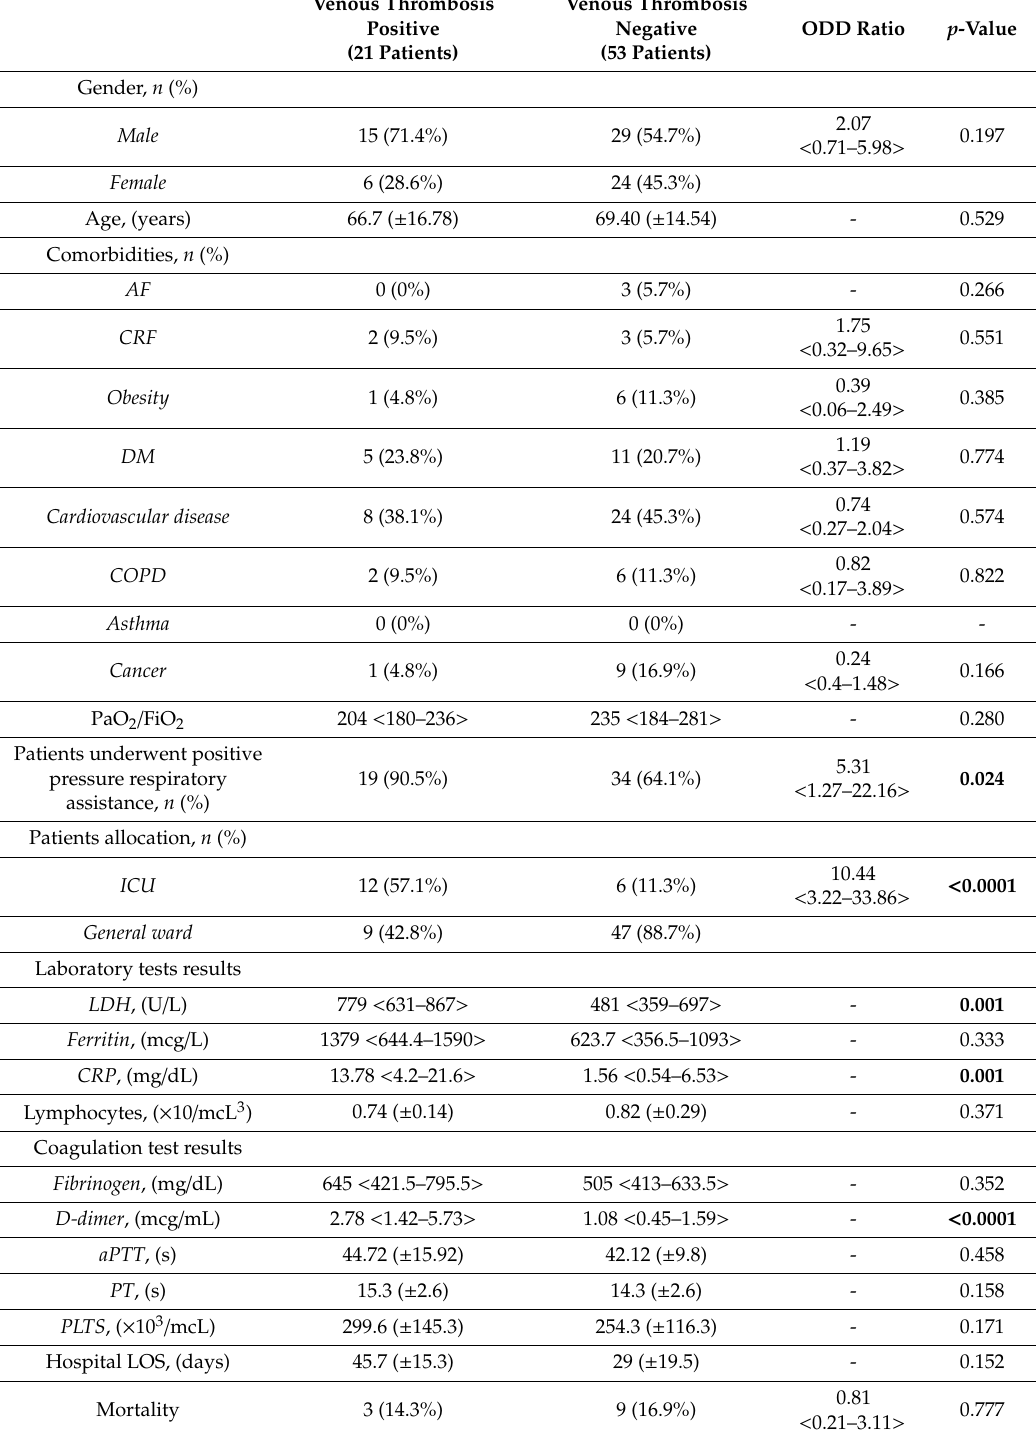
Table 3. Association analysis between venous thrombotic events and principal demographic, clinical characteristics and comorbidities. Parametric data were represented as mean (standard deviation) and non-parametric data as median < 1st, 3rd interquartile >